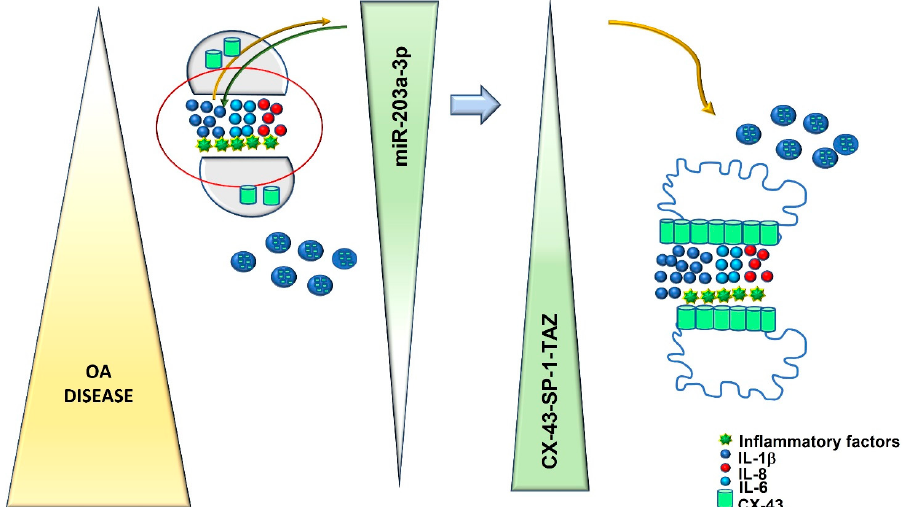
Figure 9. Graphical representation of our hypothesis of the involvement of miR203a-3p in OA disease progression (left part represents the early stage of OA, while the right part shows the middle stage of OA). The yellow and green arrows highlight the co-regulation between IL-1 β and miR203a-3p that supports the expression of the proinflammatory factors IL-6 and IL-8 and the trafficking of CX-43 from cells to exosomes, in order to improve the aggressiveness of OA during the time period.